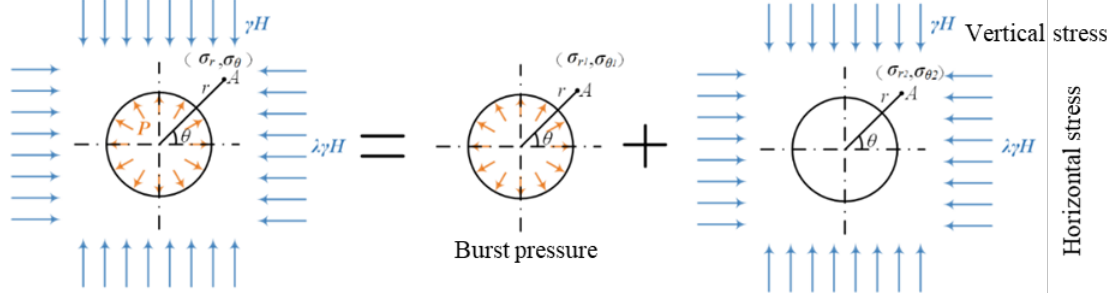
Figure 7. Stress analysis of borehole.